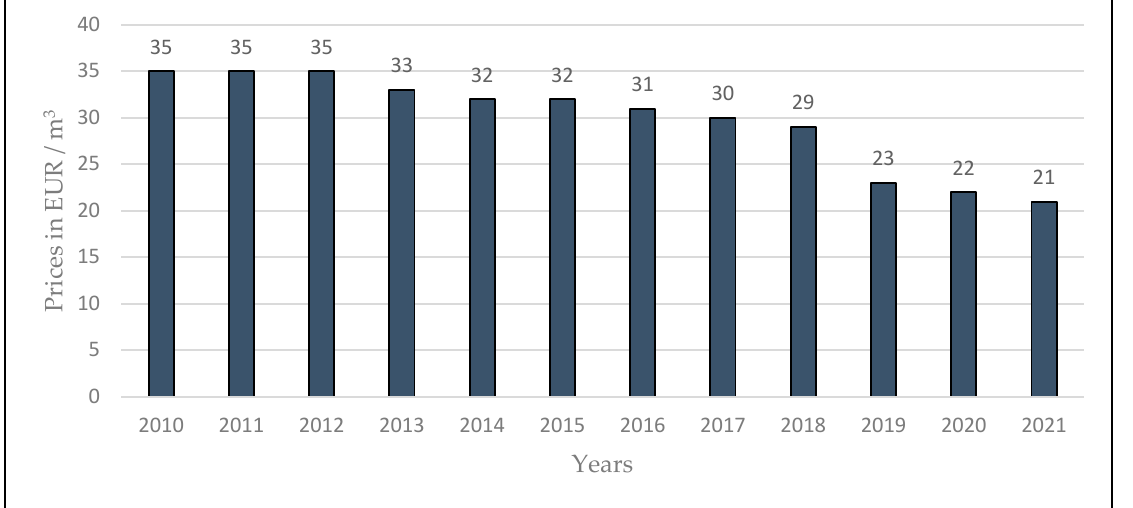
Figure 2. The Development of firewood prices and estimate for 2021 (Czech Republic); Source: Č SU (Czech Statistical Agency) 2020, Forestry.